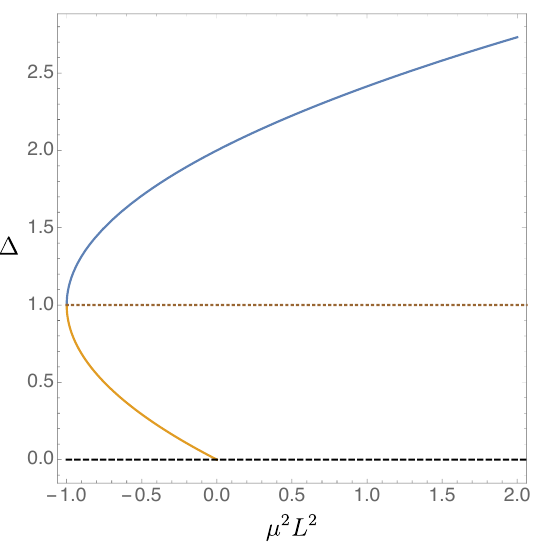
Figure 2 . The conformal dimension (cid:1) as a function of the scalar (cid:12)eld mass (cid:22) 2 L 2 . The upper branch (blue) corresponds to (cid:1) + , the lower branch (orange) to (cid:1) (cid:0) . Note (cid:1) (cid:6) ( (cid:22) BF ) = 1 and (cid:1) (cid:0) (0) =